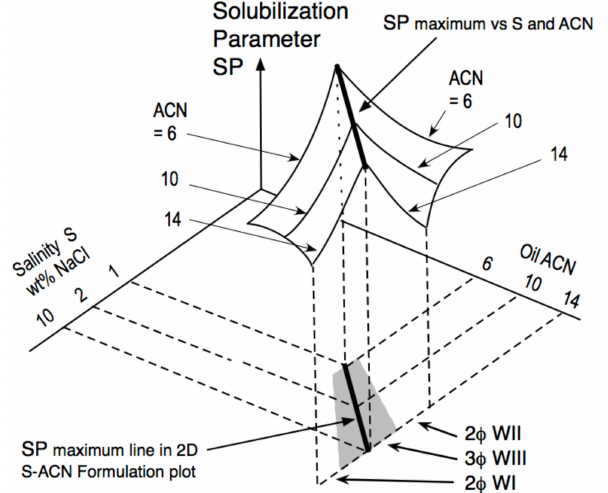
Figure 9. Solubilization as SP parameters (essentially indicating the performance index PERFIND) vs two formulation variables, i.e., water salinity (as S or ln S) versus oil ACN. The projection on the lower S-ACN plane of this 3D black line for solubilization maximum is another black line (called SP maximum line in 2D) which is found in the middle of a grey zone that indicates a three-phase WIII region. The same kind of result is attained if the performance is measured with the interfacial tension, looking for the minimum value to determine the optimum in a scan